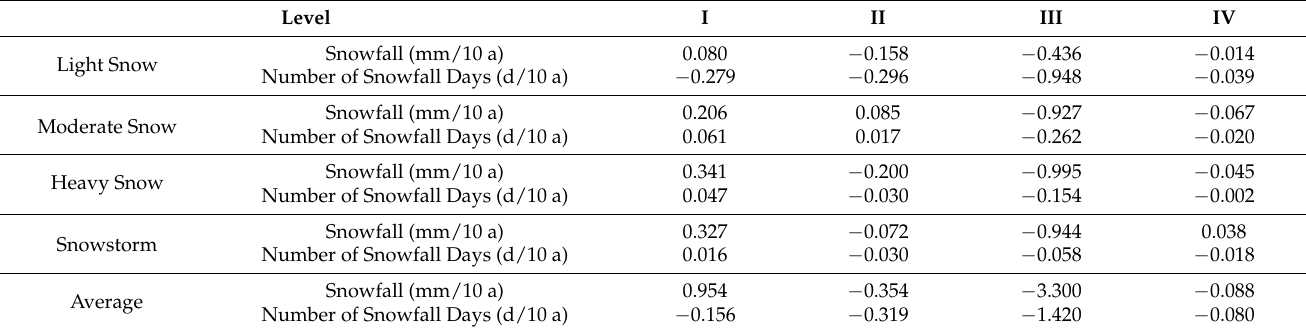
Figure 5. Interannual variations in the snowfall and number of snowfall days at different levels in Zone I in the Haihe River Basin. Table 5. Interannual variation trends in the snowfall at different levels in the Haihe River Basin.